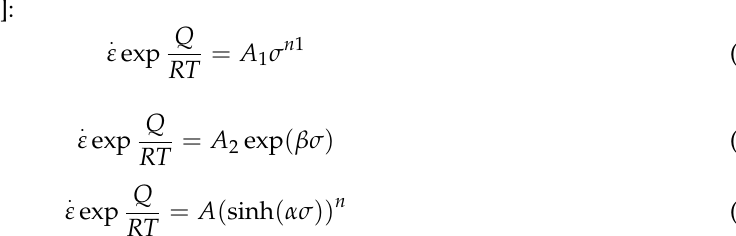
. . ε = 1s − 1 ; ( d ) ε = 10s − 1